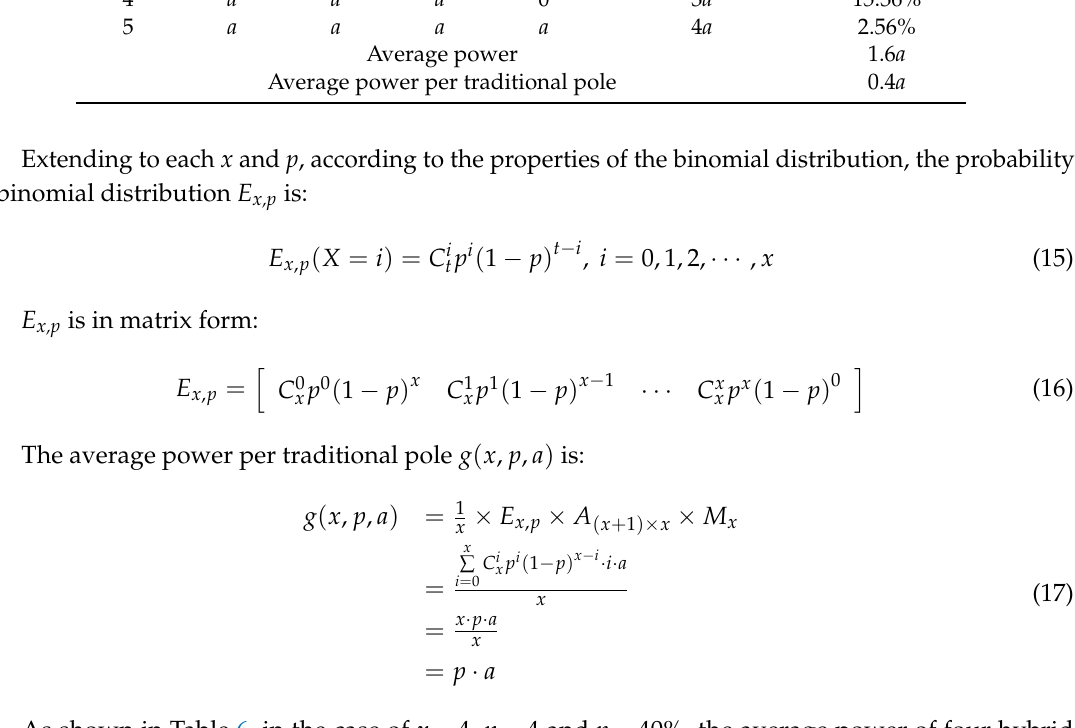
Average power 1.6 a Average power per traditional pole 0.4 a